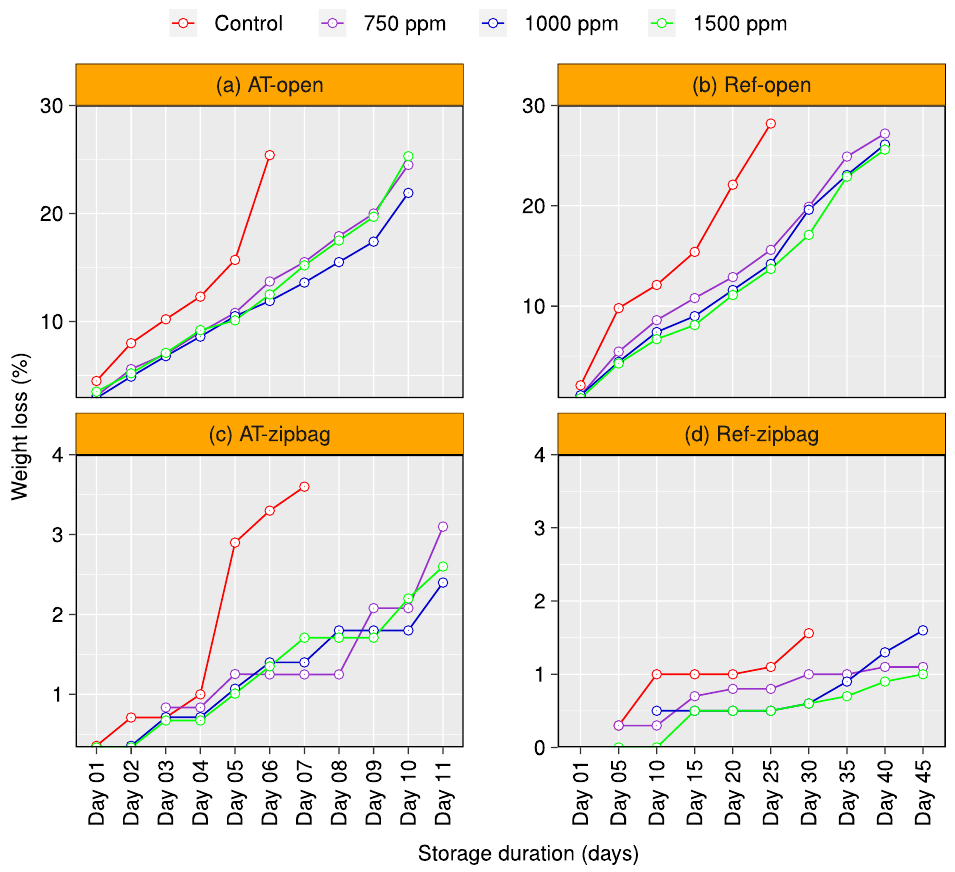
Figure 2. Evaluation of weight loss (%) of chitosan-treated and untreated Gopal vogh mango stored in the open or in zip-bags at ambient temperature and refrigeration (Ref) temperature ( a – d